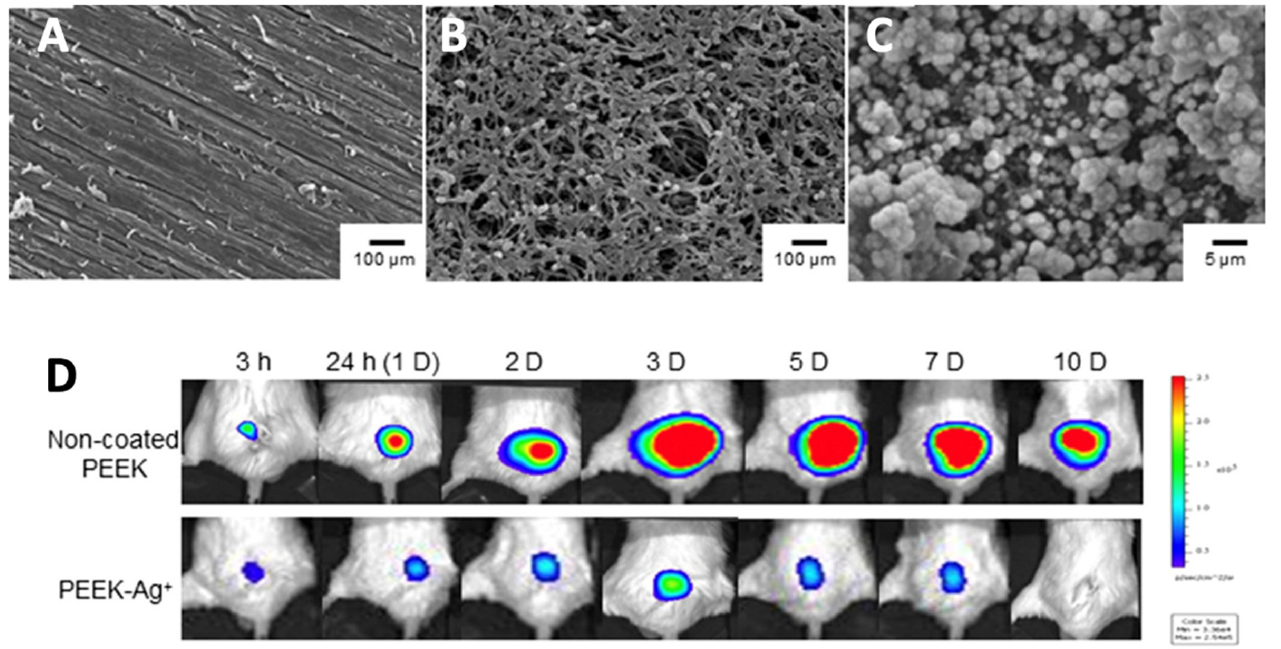
Figure 4. Example of an ionic silver antimicrobial coating immobilized onto hydroxyapatite covering a polyether–ether–ketone (PEEK) implant coating. The surface of PEEK ( A ) was immersed in 98% concentrated sulfuric acid (H 2 SO 4 ) for 10 min ( B ), after which a porous configuration was observed on the surface by SEM. ( C ) Hydroxyapatite aggregates were homogeneously coated on the PEEK coated with immobilized Ag + ions (PEEK-Ag + ). ( D ). Sequential analysis of the bacterial bioluminescence in the mouse soft tissue infection model, where a non-coated PEEK of PEEK-Ag + plate was placed into the superficial gluteus muscle of mouse, followed by inoculation with a bioluminescent strain of S. aureus . The bacterial photon density was measured at 3, 12 and 24 h, and then each day until 10 days after the operation). Modified and reproduced from [190] under CC BY 4.0